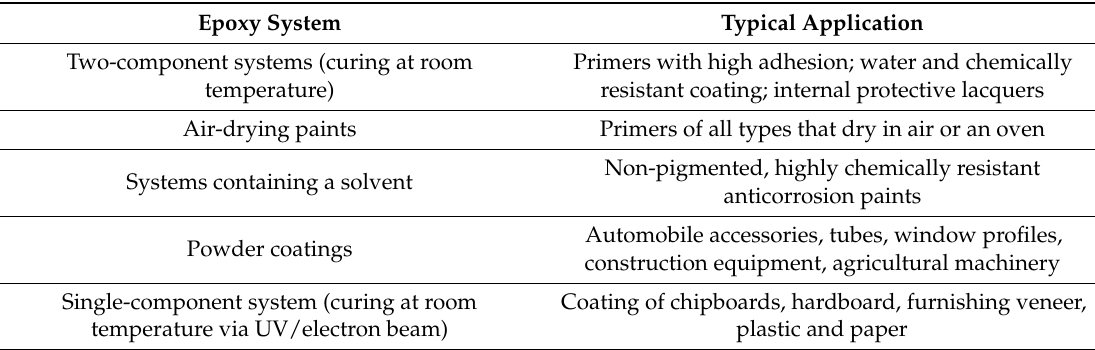
Table 1. Epoxy gelcoat systems and their typical